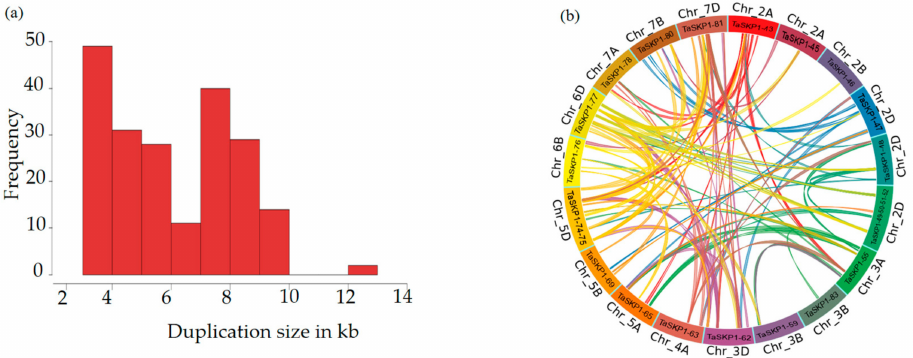
Figure 4. ( a ) Frequency and size of duplicated regions on the wheat genome and ( b ) duplicate events in the relevant phylogenetic clades. Each connection represents a duplicated sequence with a minimum size of 3 Kb and at least 90% nucleic